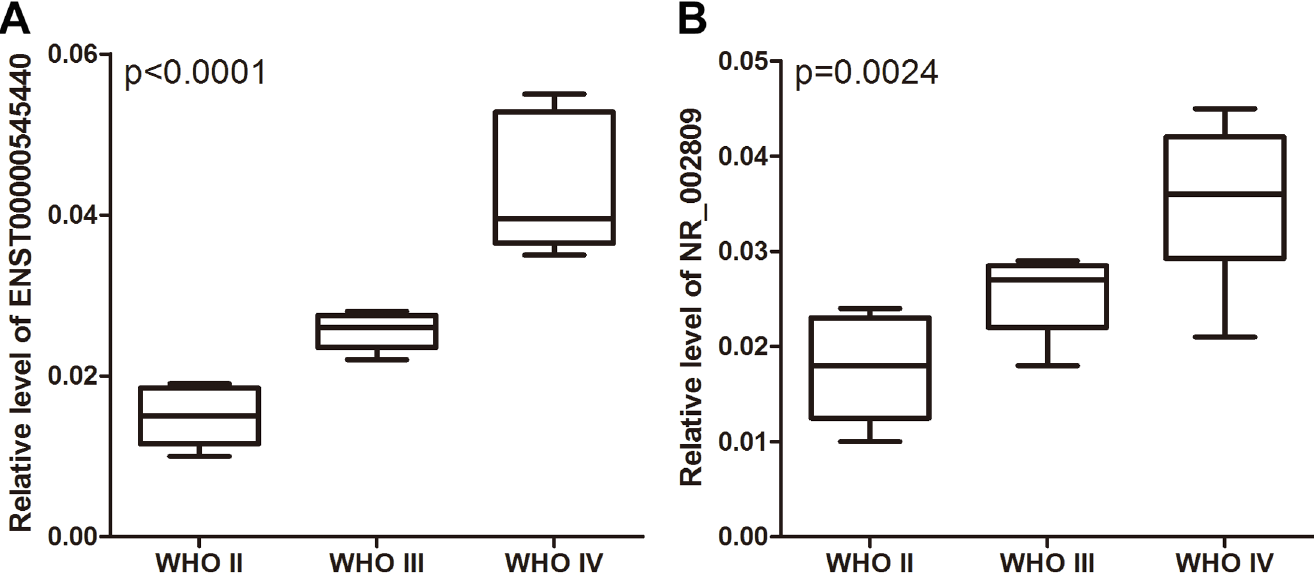
Fig 2. The levels of lncRNA expression in the astrocytoma patients stratified by tumor grade. The relative expression levels of ENST00000545440 and NR_002809 in each group are